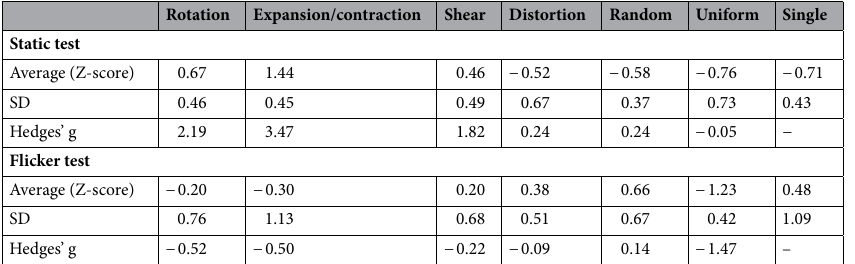
Table 1. Z-score and Hedges’ g of Experiment